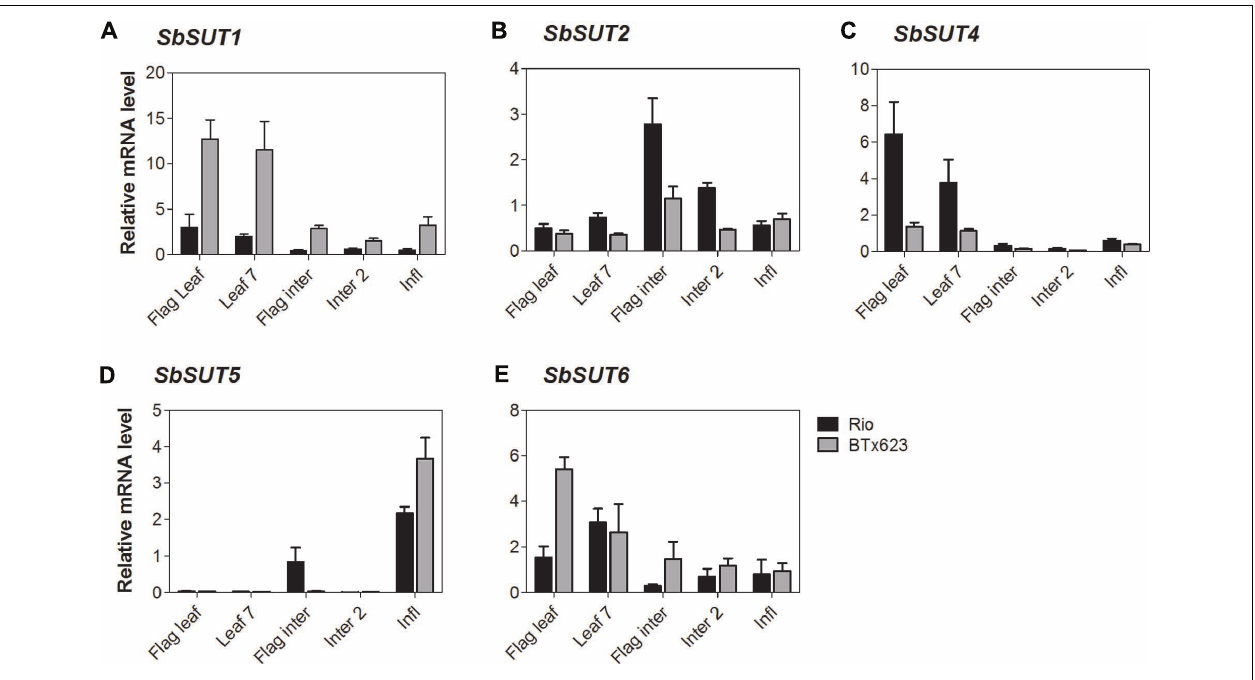
FIGURE 6 | Sorghum SUT transcript levels at anthesis. Relative expression at anthesis of Sorghum SUTs (A) SbSUT1 ; (B) SbSUT2 ; (C) SbSUT4 ; (D) SbSUT5 ; (E) SbSUT6 . Levels of SUT expression were measured